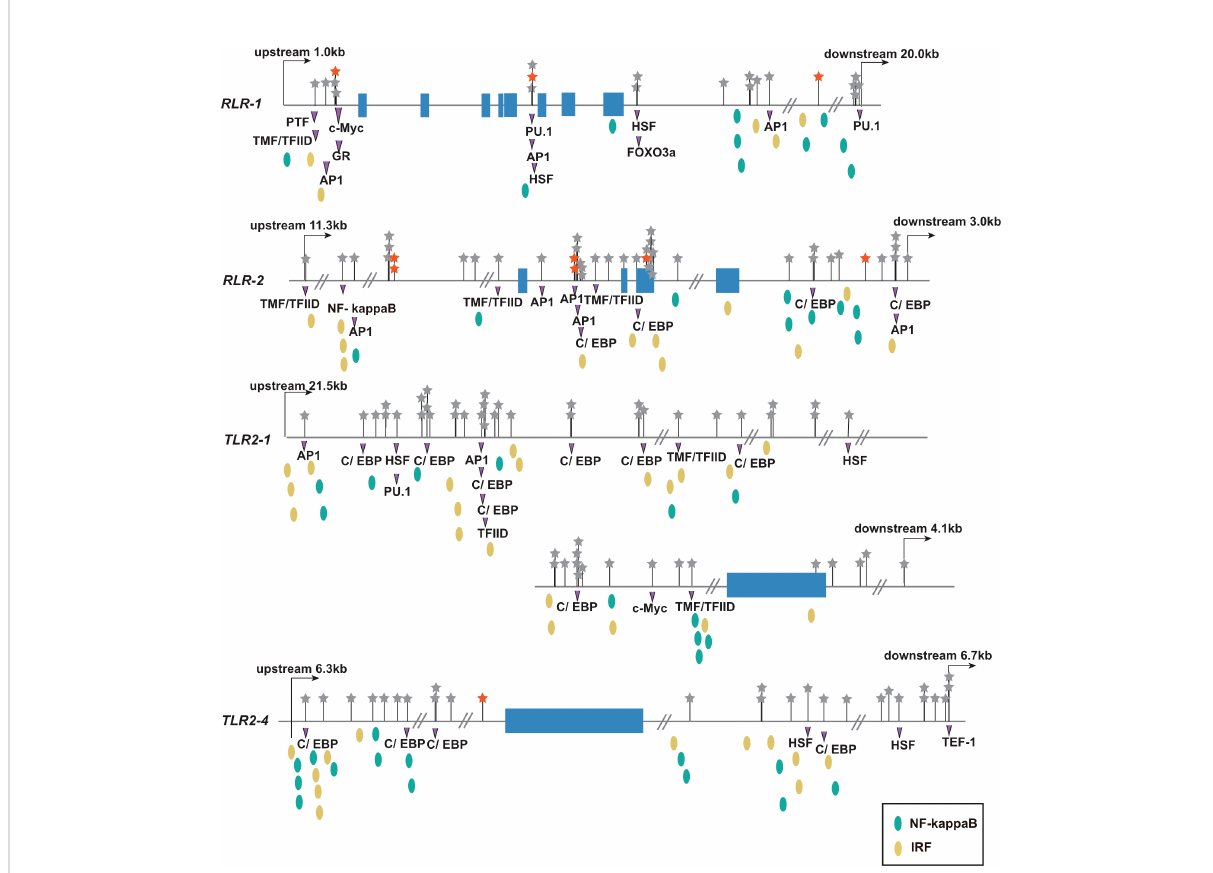
FIGURE 6 Distribution of polymorphism and transcriptional factor binding sites at four pattern recognition receptors ( RLR-1 , RLR-2 , TLR2-1 , and TLR2-4 ) associated with OsHV-1 caused mortality. The blue rectangles are exons. The stars represent SNPs, and the red stars indicate SNPs whose allele frequency changes is no less than 0.5. The purple triangle represents the predicted transcription factor binding sites that covers SNPs. The canonical antiviral transcription factor binding sites IRF and NF-kappa B near SNPs are marked with yellow and green ellipses,